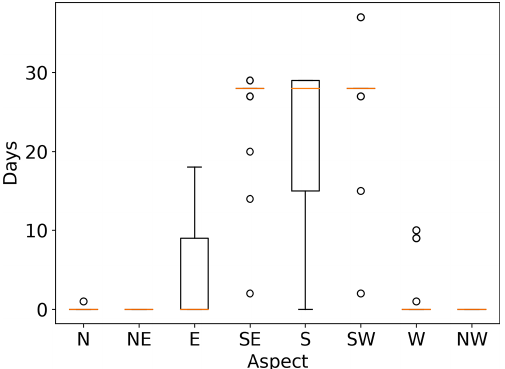
Figure 9. Impact of the dust deposition on reaching the LWC threshold. For each aspect, the difference in date when the threshold was reached was calculated between the dust and the no-dust sim- ulation. The main body of the boxplot spans the interquartile range from the first to the third quartile of the data, while the horizontal orange lines show the median. The whiskers show the range of ob- served values that fall within 1.5 times the interquartile range, and the black circles represent